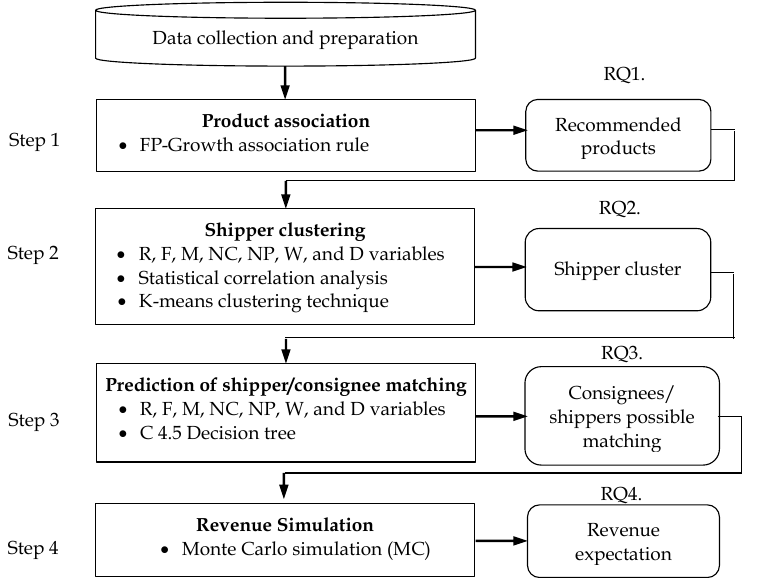
Figure 1. Research Figure 1. Research methodologies